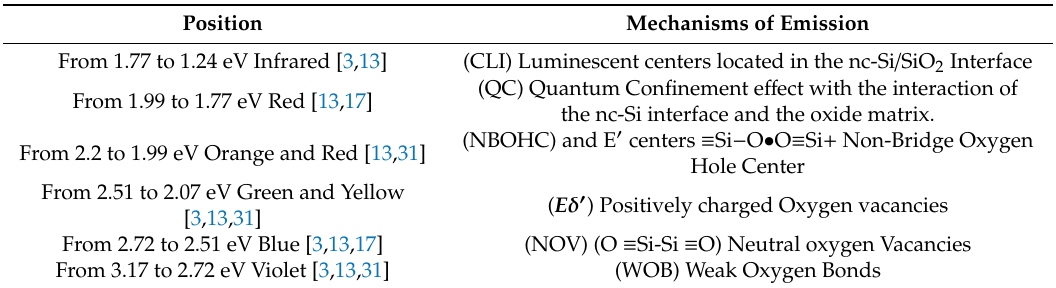
Table 7. Emission mechanisms of the SRO